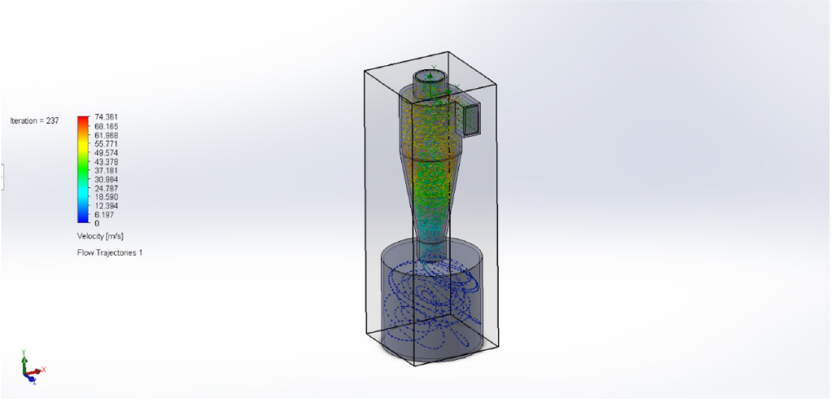
Figure 20. Fluid simulation of cyclone separator.